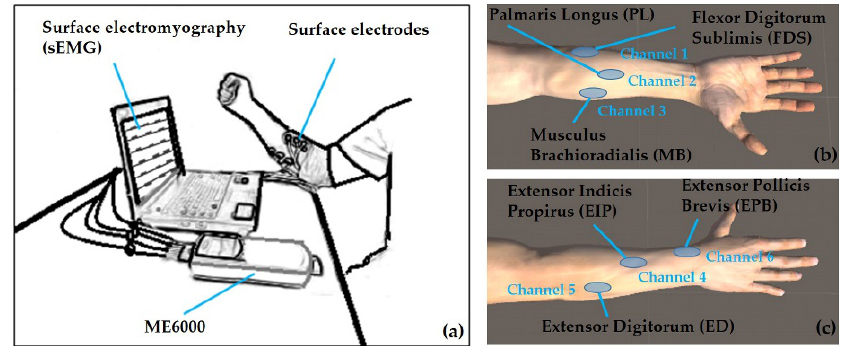
Figure 1. The experiment set-up for the sEMG recording during the hand movement. ( a ) A diagram of the experiment scene. The surface electrodes placement were configurated to muscles as Channel (Muscle): ( b ) Channel 1 (FDS), Channel 2 (PL), Channel 3 (MB) and ( c ) Channel 4 (EIP), Channel 5 (ED), Channel 6 (EPB).